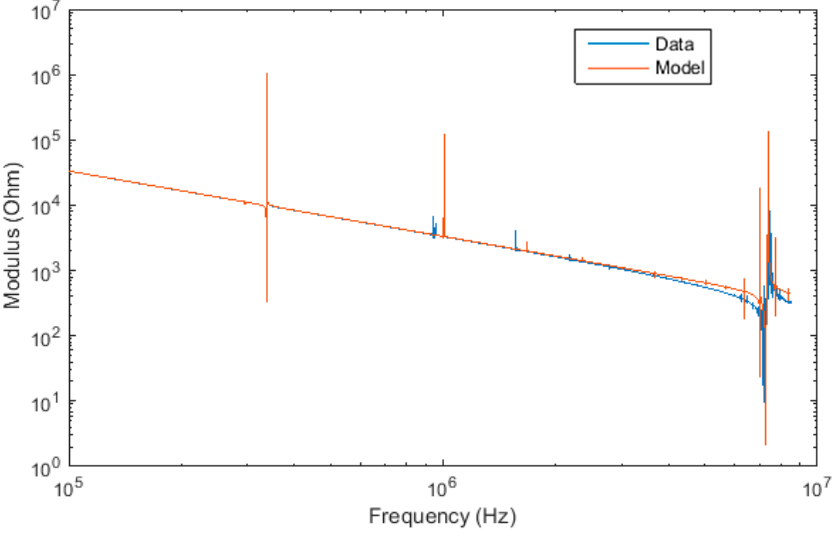
Figure 2. Model fitting on the impedance modulus spectrum of the Z-cut sample.